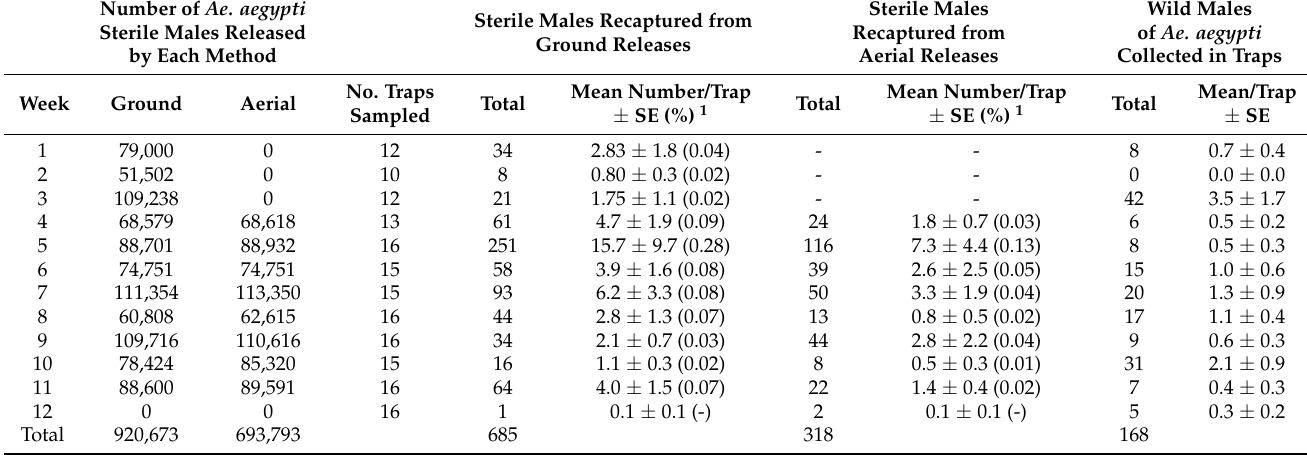
Table 1. Number of sterile male Aedes aegypti released using ground and aerial methods and captures of sterile and wild males in BG-traps in Hidalgo village during a 12-week